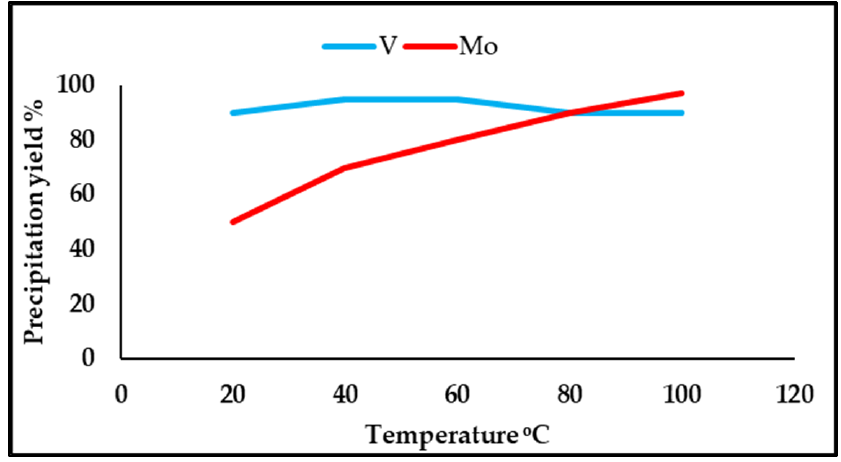
Figure 5. Precipitation yield of molybdenum and vanadium vs. temperature (V: pH 9, time 60 min.; Mo: pH 1, time 60 min.).